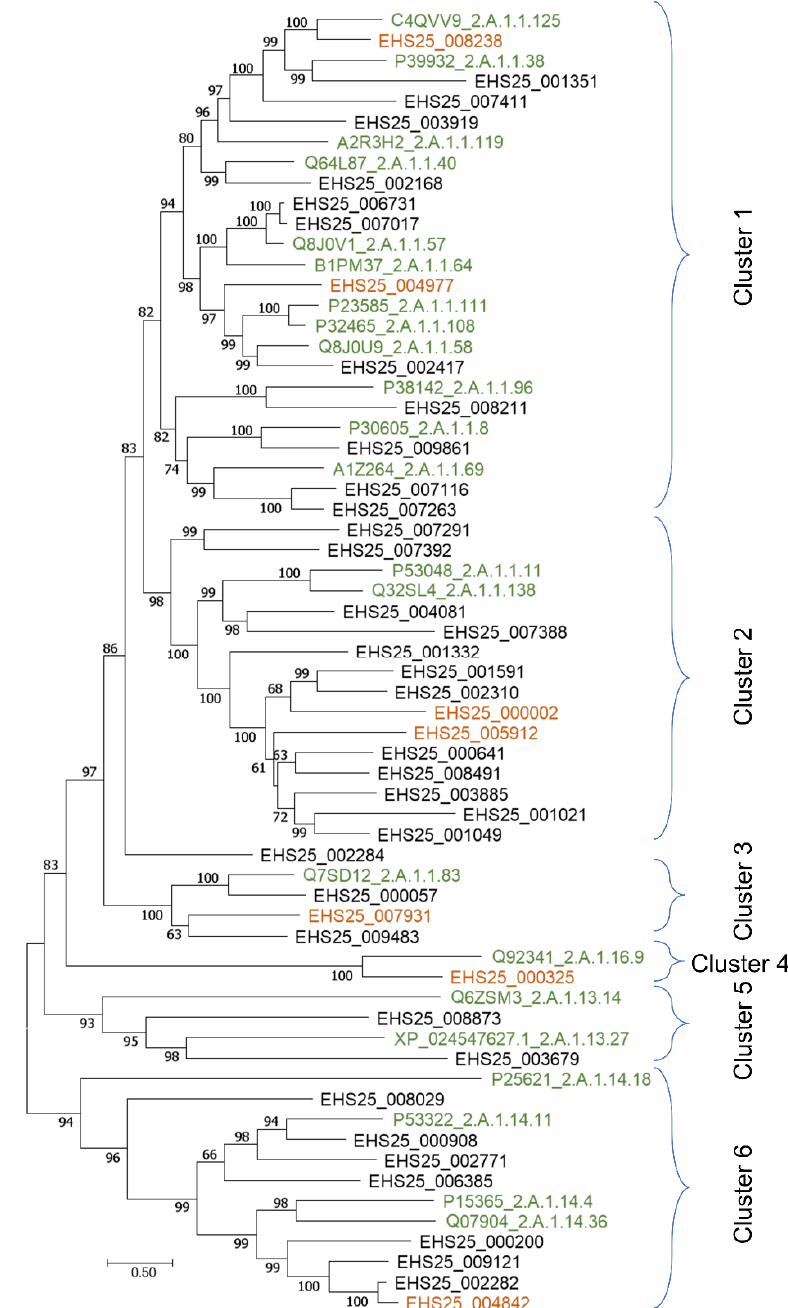
Figure 3. Maximum likelihood phylogeny of sugar (other) transport proteins predicted from overexpressed genes in Saitozyma podzolica DSM 27192 during initial growth (22 h time point) on glucose and xylose. The tree was generated using the trimmed alignment (364 amino acids) of 64 protein sequences, including 22 closest references from TCDB based on LG + F+ R6 model with -bb 1000 using IQ-TREE v1.6.11. Orange and black fonts indicate overrepresented proteins (translated genes) in glucose and xylose, respectively, while green fonts represent top matching proteins from the transporter classification database. The alignment was generated using transmembrane proteins (PSI/TM-Coffee) function of T-Coffee.